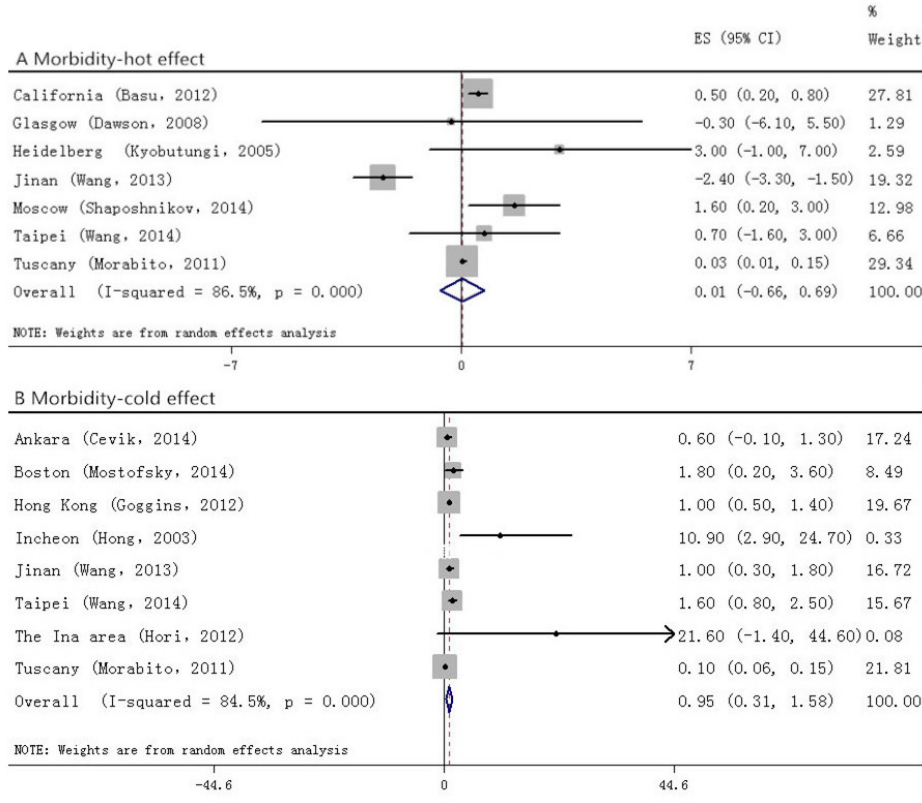
Figure 2. Forrest plots for total analyses: relationship between the temperature change and the onset of MACBE. A and B stand for hot and cold effect, respectively.